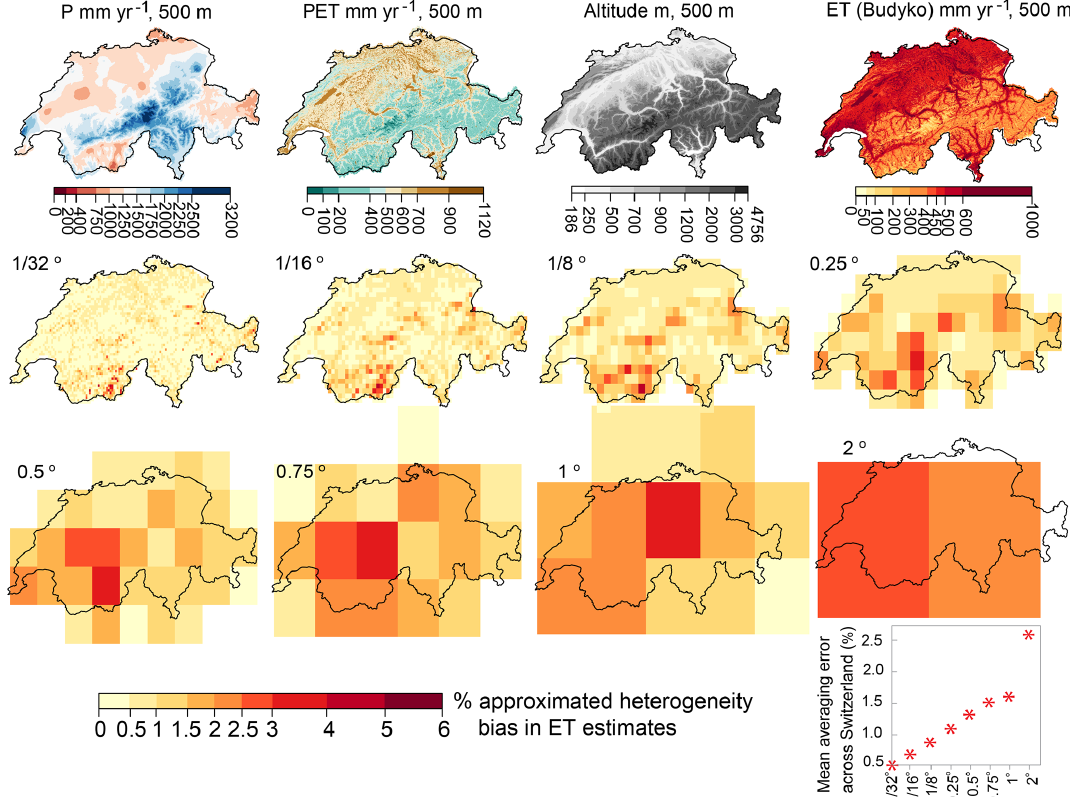
Figure 6. Heterogeneity bias in ET estimates at various scales across Switzerland, estimated from 500m climate data. ET is calculated using the Budyko relationship (Eq. 1). Heterogeneity bias was estimated from 500m precipitation ( P ) and potential evapotranspiration (PET) and their variances at each grid scale, using Eq. (4). At finer grid resolutions, the heterogeneity bias is more localized and smaller on